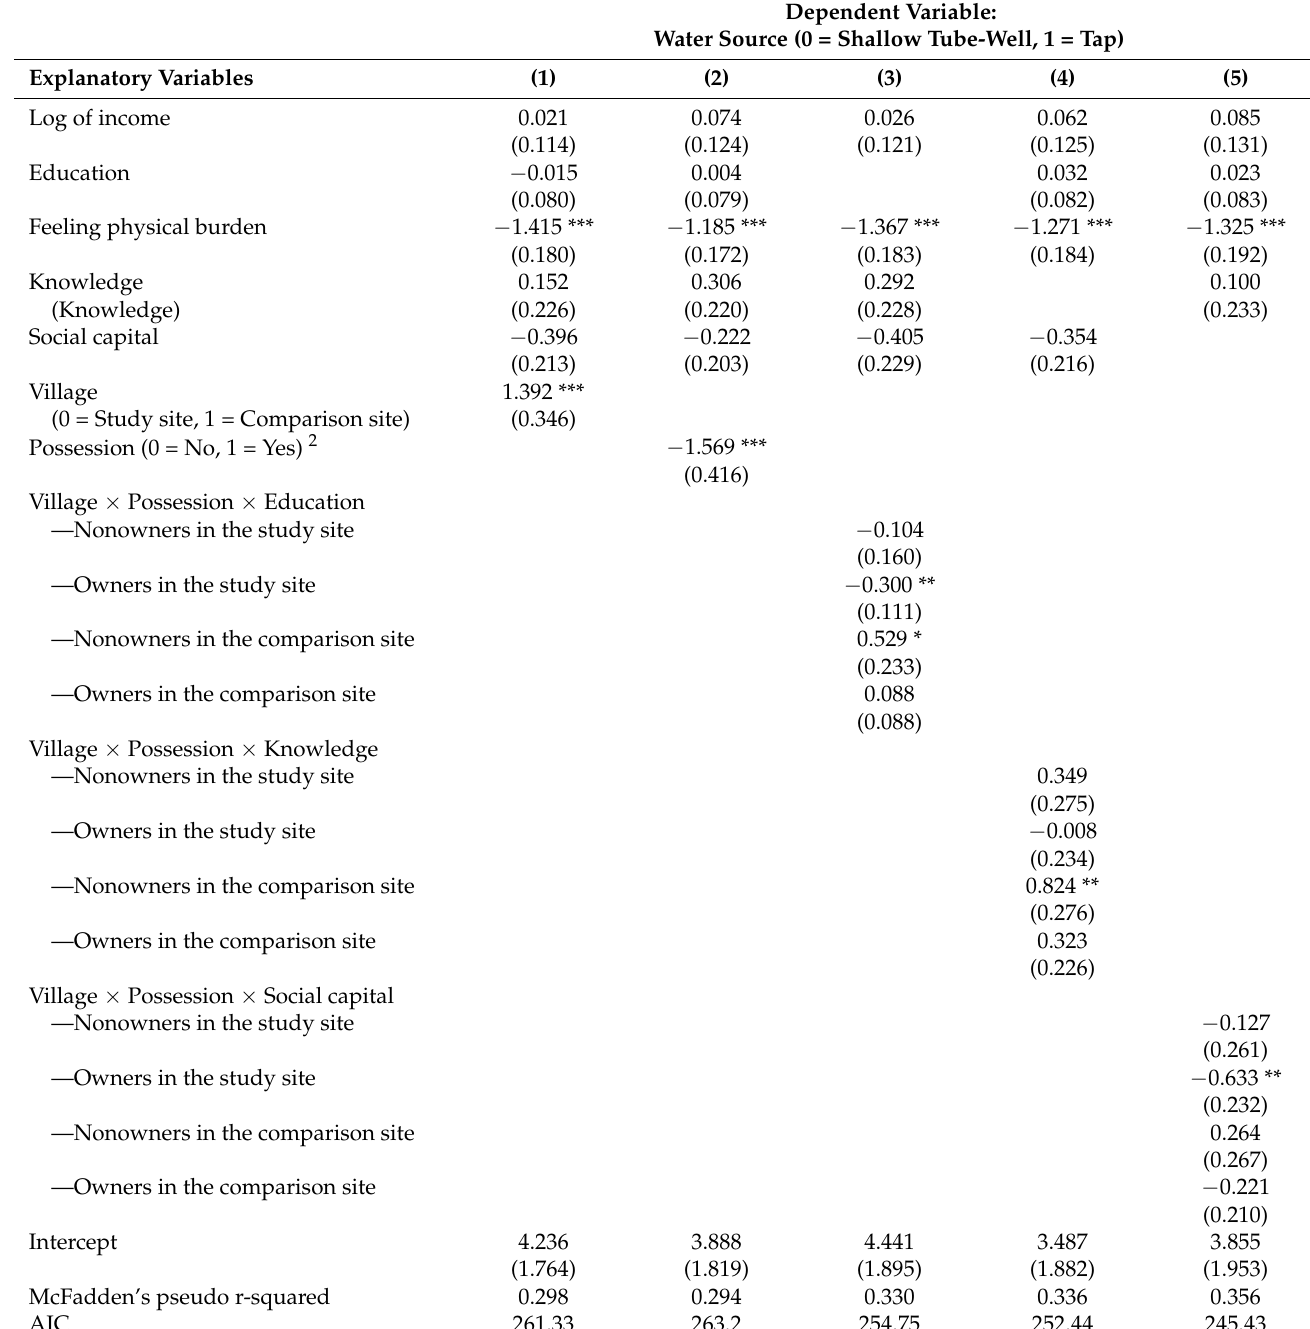
Tables 6 and 7 show the results on the five logistic regression models for each water use purpose with different specifications. Table 6. Logistic regression results for determining likelihood of drinking water source selection (N = 255) 1 . Dependent